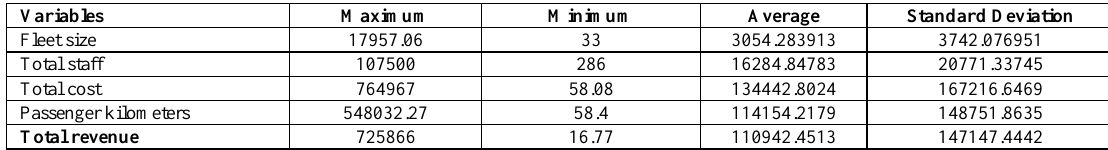
Table 1. Descriptive statistics of variables